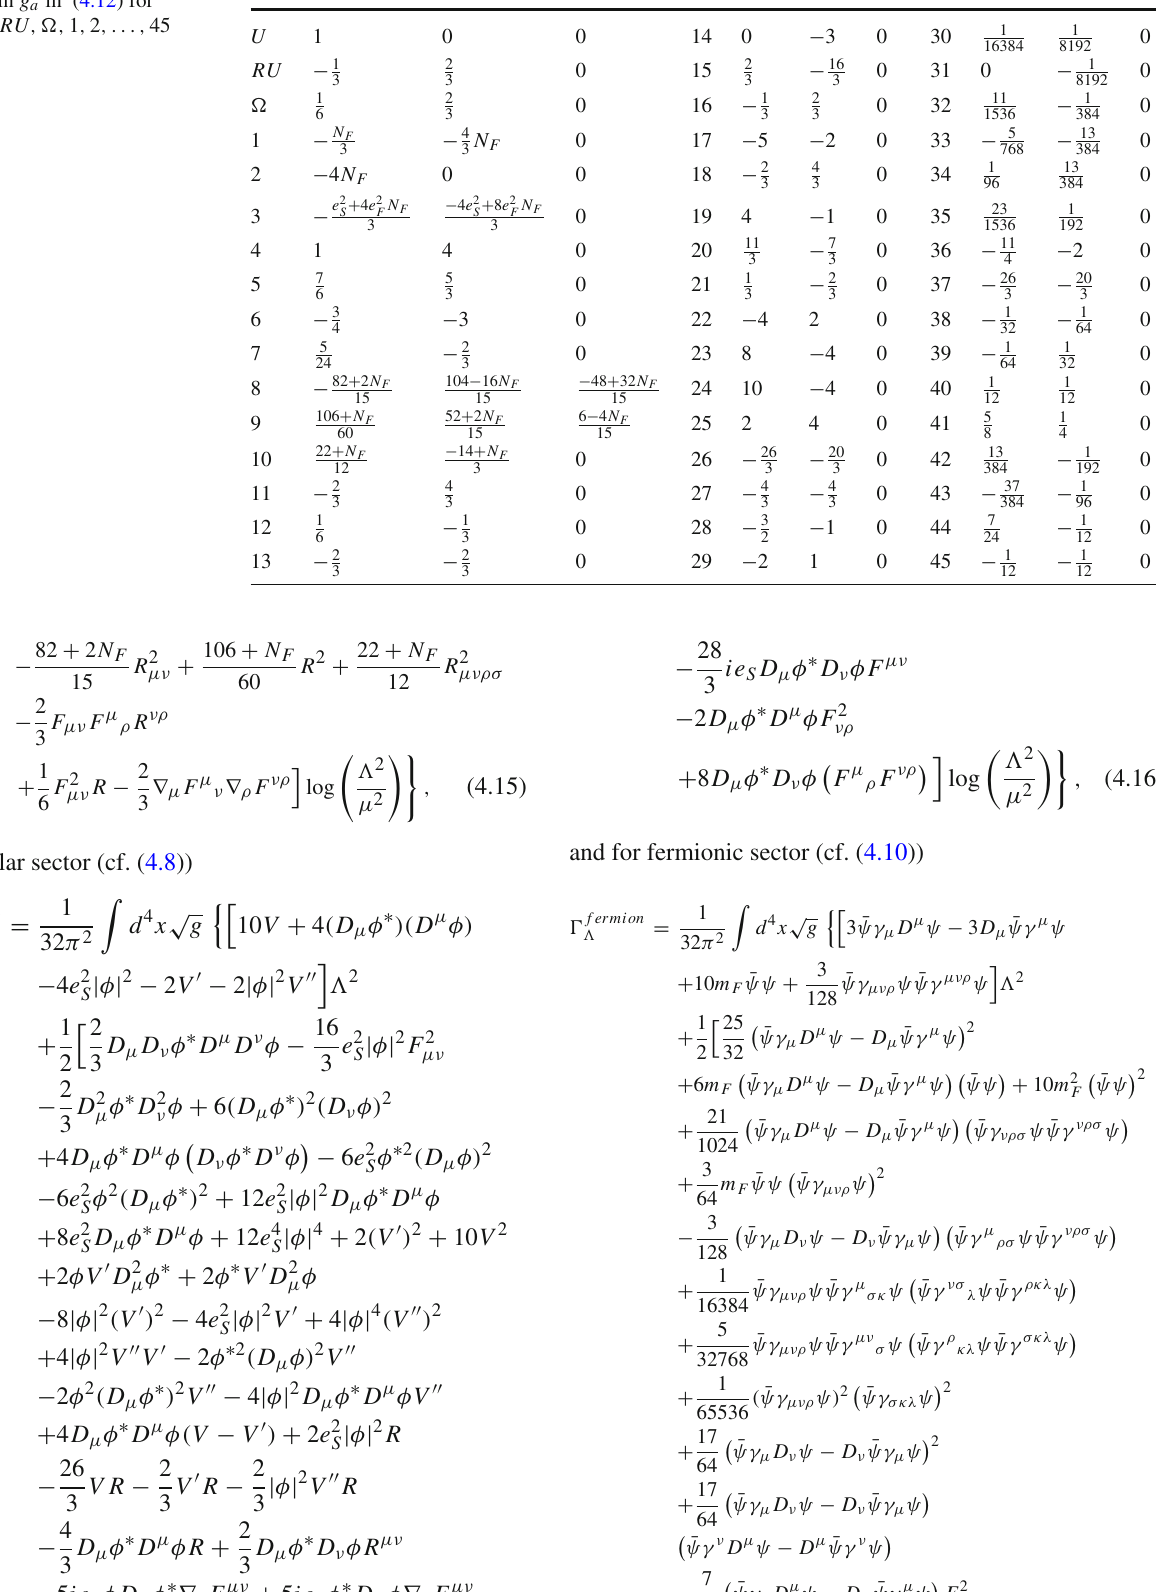
Table 1 Coefficients A a , B a and C a in g a in (4.12)